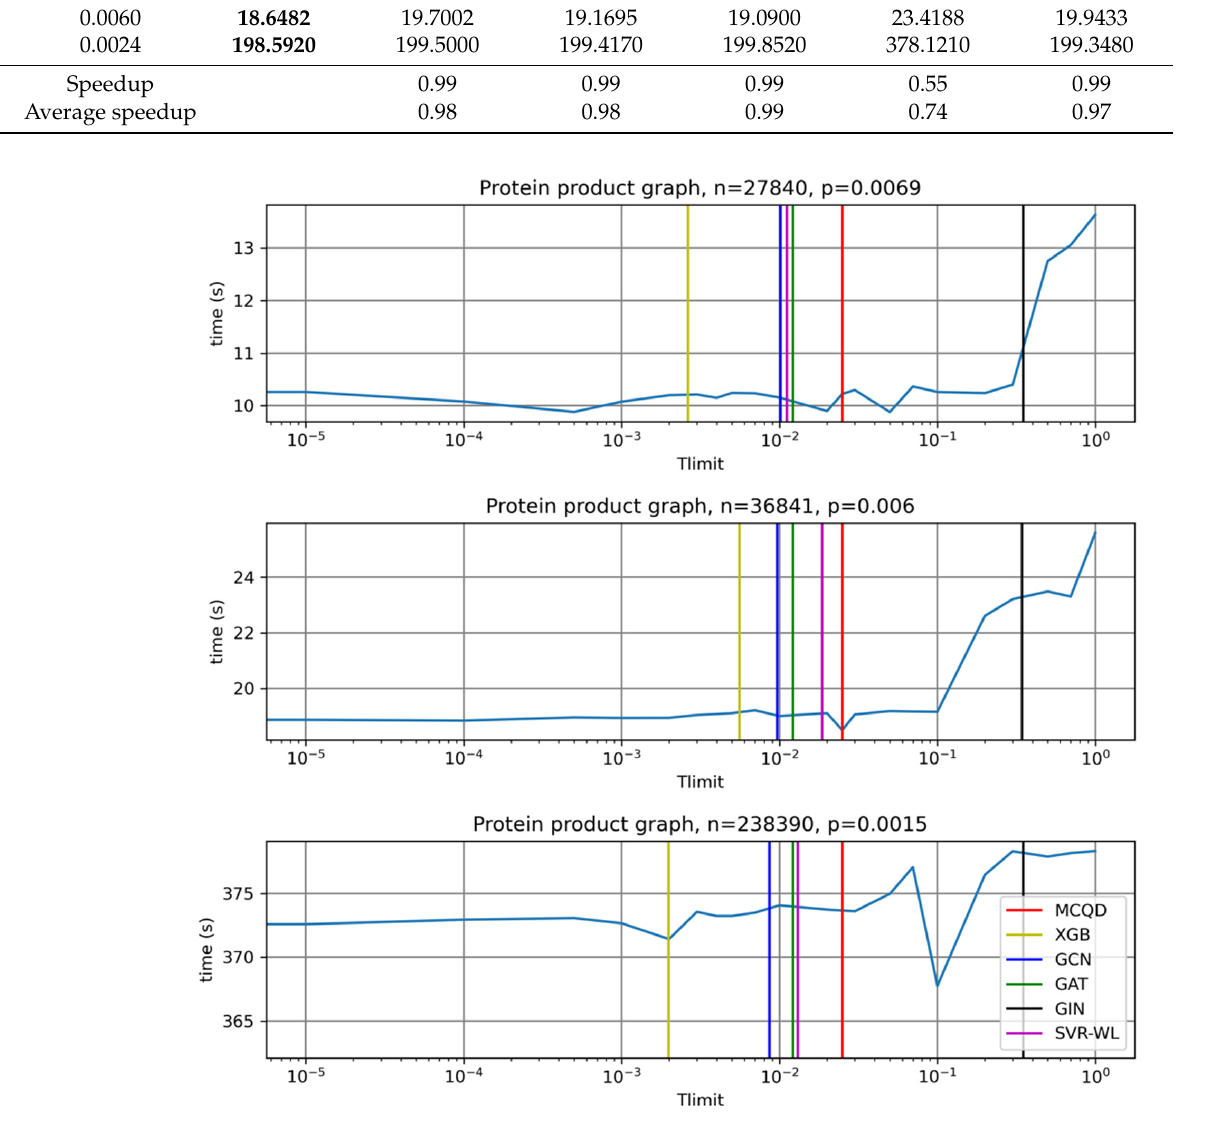
Figure 5. Time needed by MCQD algorithm and each variant of the MCQD-ML algorithm to find a maximum clique on three different graphs from test set of protein product graphs dependent of Tlimit parameter.